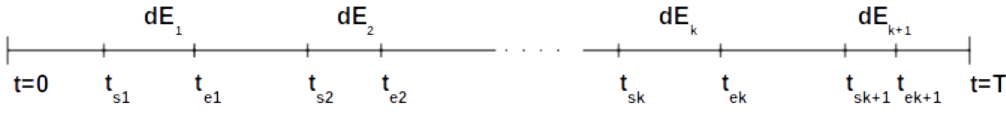
Figure 4. Disconnection events representation. The disconnection events dE k can appear distributed along the exploration timeline. Its last is variable and depends on the movements realised by the fleet during the exploration. The starting and ending times of each disconnection are represented by the timestamps t i and t i , respectively. sk ek